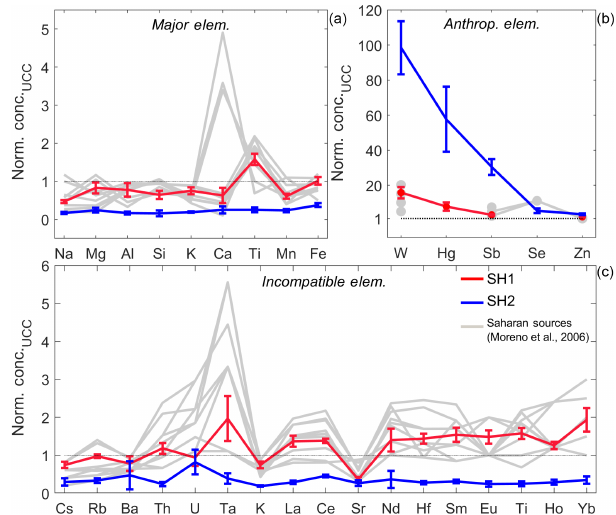
Figure 8. The elemental composition of the Saharan dust extracted from the snow precipitated on the Alps in February 2014 (red line, SH1), and the composition of the particulate matter retrieved from the clean snow deposited few days later (blue line, SH2). Grey lines refer to samples collected from the Sahara–Sahel dust corridor (Moreno et al., 2006). Data are expressed in terms of concentration normalized to the average upper continental crust (UCC; Rudnick and Gao, 2003). (a) Major elements, (b) anthropogenic elements, and (c) incompatible elements (with respect to Fe), listed following the order proposed by Sun and McDonough